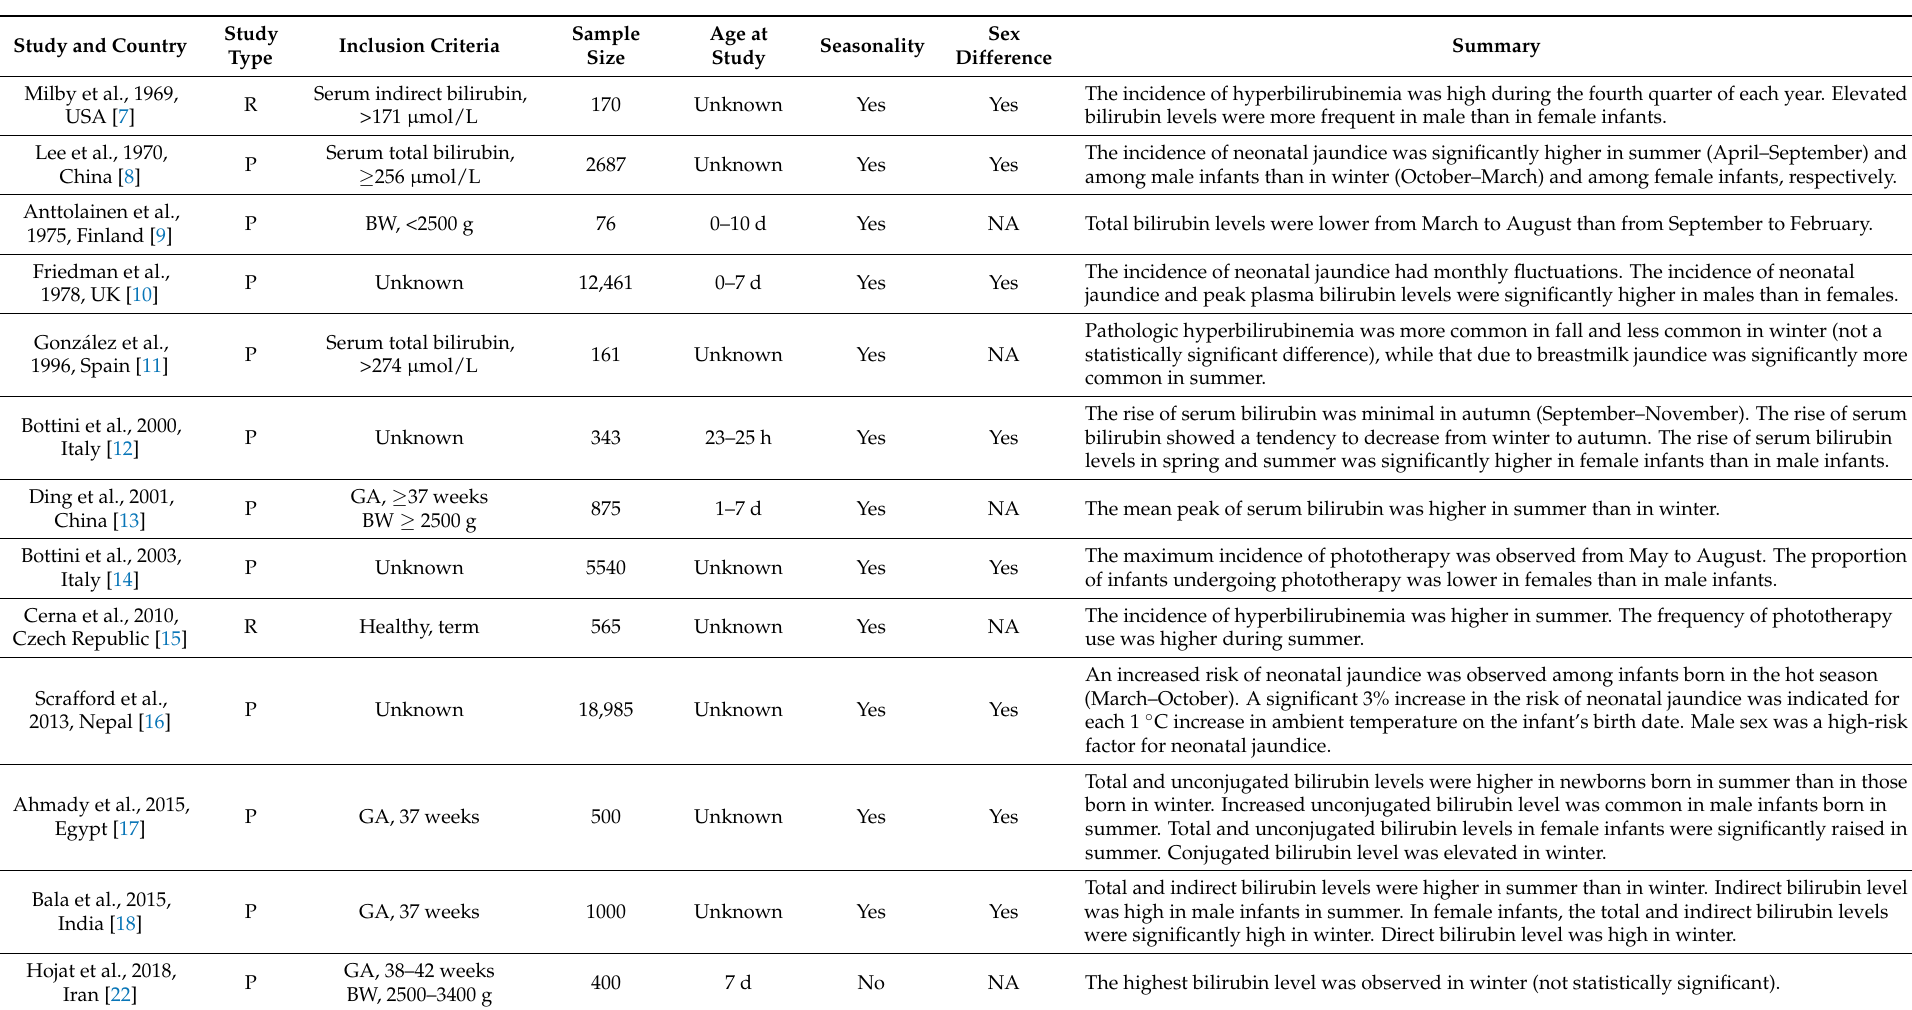
Table 3. Reports investigating the seasonal variation in serum bilirubin levels and hyperbilirubinemia in